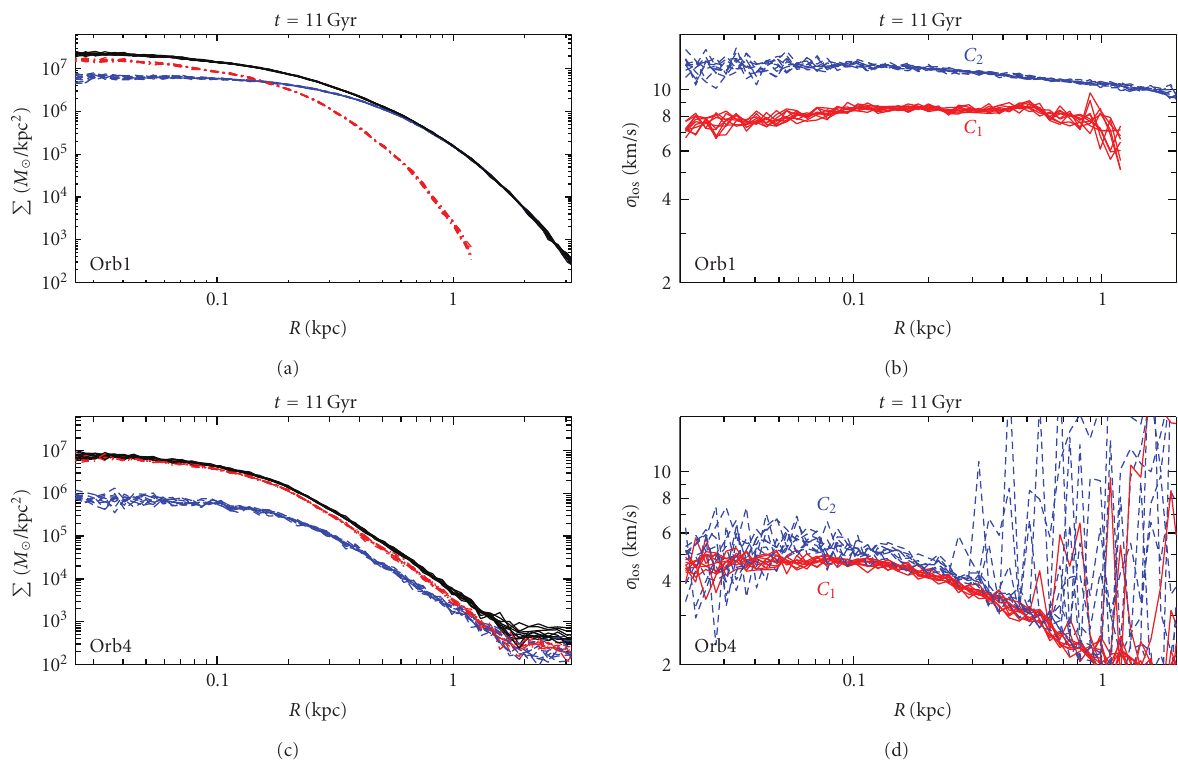
Figure 7: Projected density (a) and velocity dispersion (b) profiles for satellites evolved in Orb1 and Orb4 for a longer time interval: t ∼ 11Gyr, instead of the fiducial t ∼ 6Gyr. Notice for Orb4 that, as mass depletion proceeds further, the spatial and kinematical segregation between C 1 and C 2 is increasingly